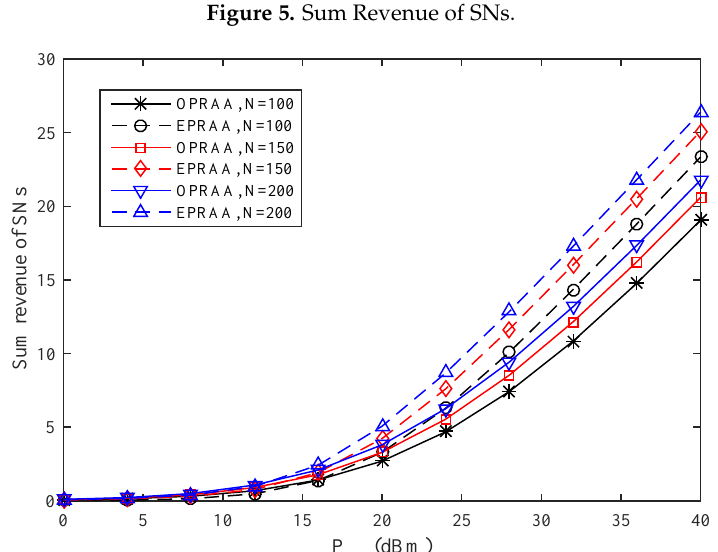
Figure 5. Sum Revenue of SNs.